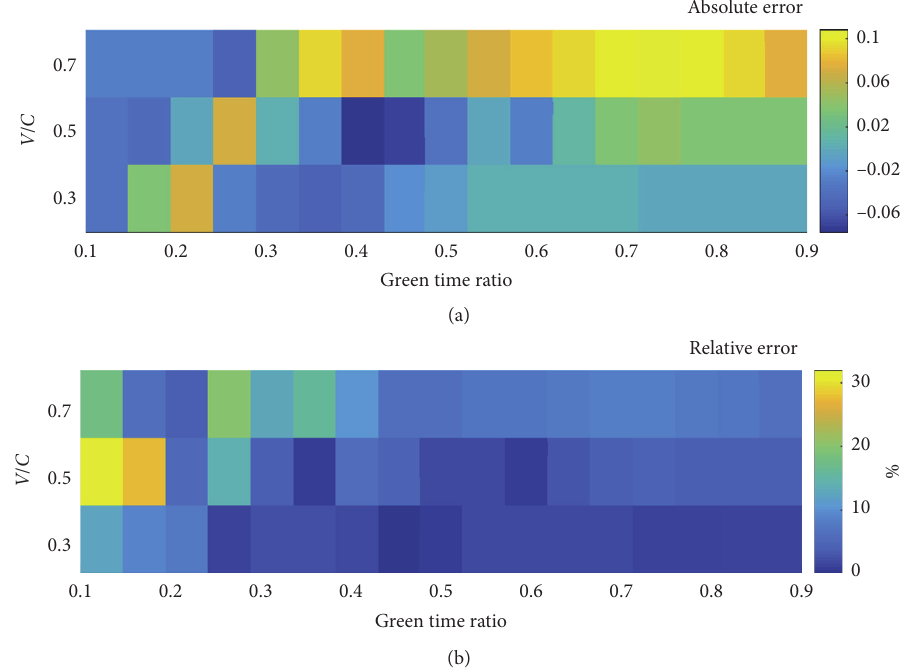
Figure 15: Absolute error and relative error between microsimulation calculation and model